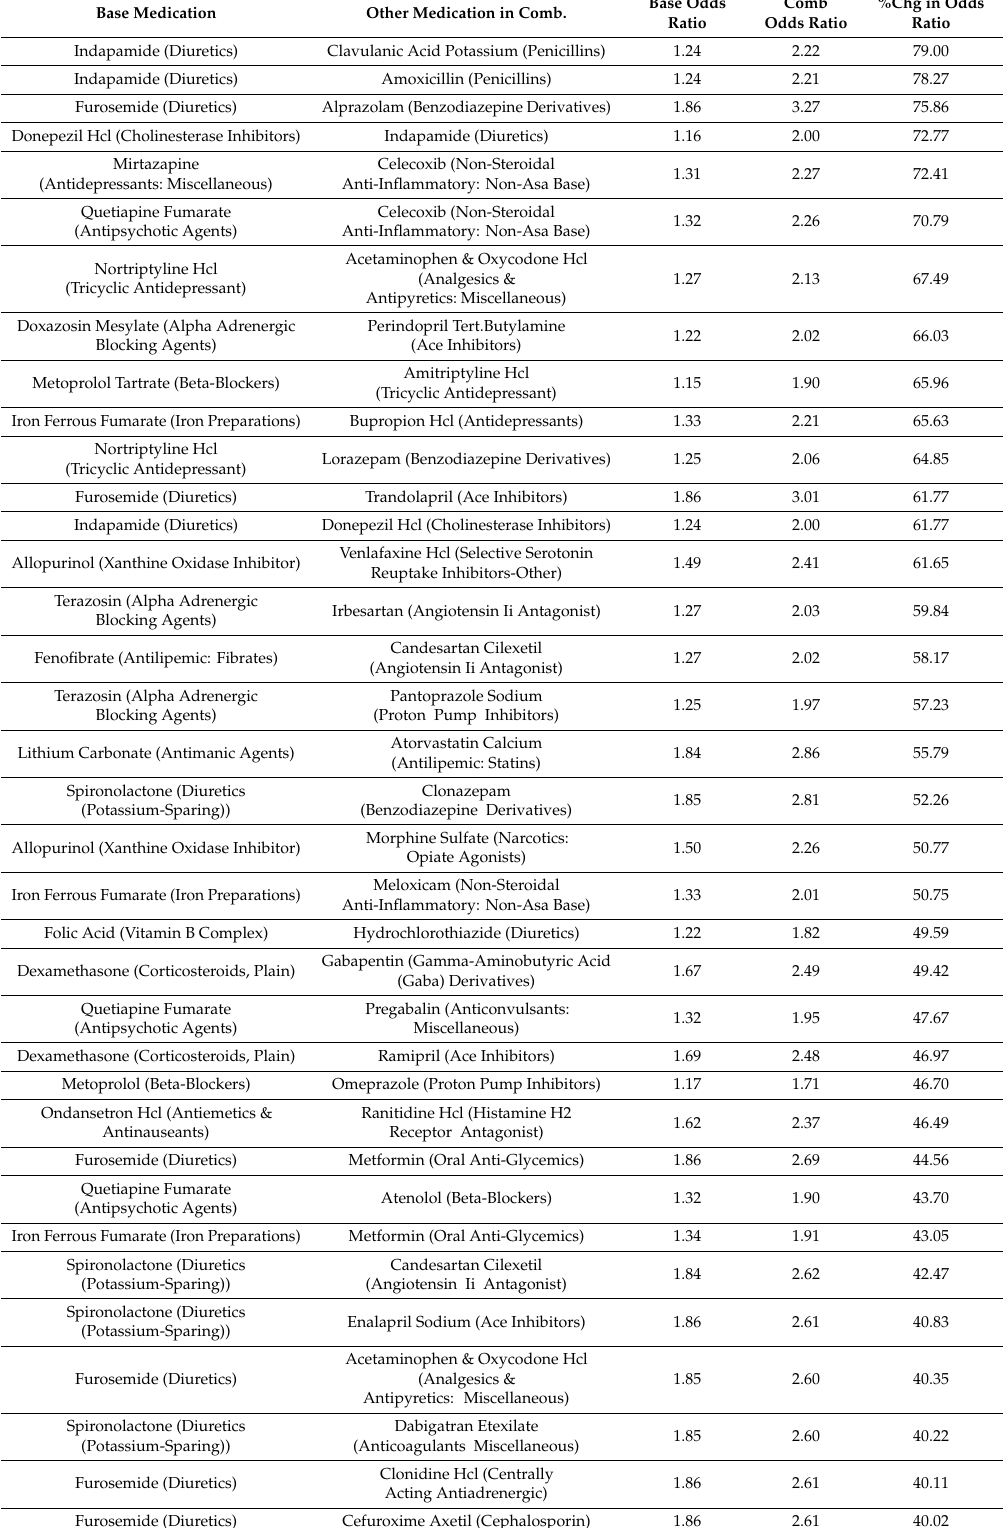
Table 3. List of the medication combinations sorted based on their percentage change in odds ratios. Base Medication Other Medication in Comb. Base Odds